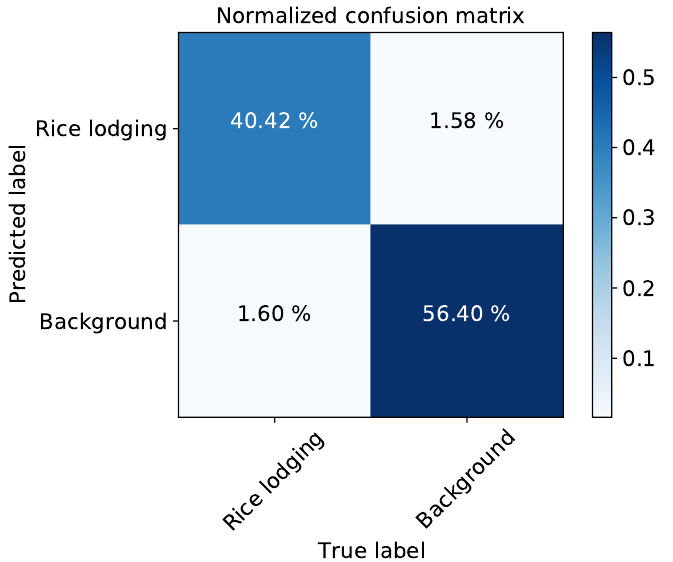
Figure 6. Predicting rice lodging using DeepLabV3+ with VGG-16 + GloAN as the backbone.